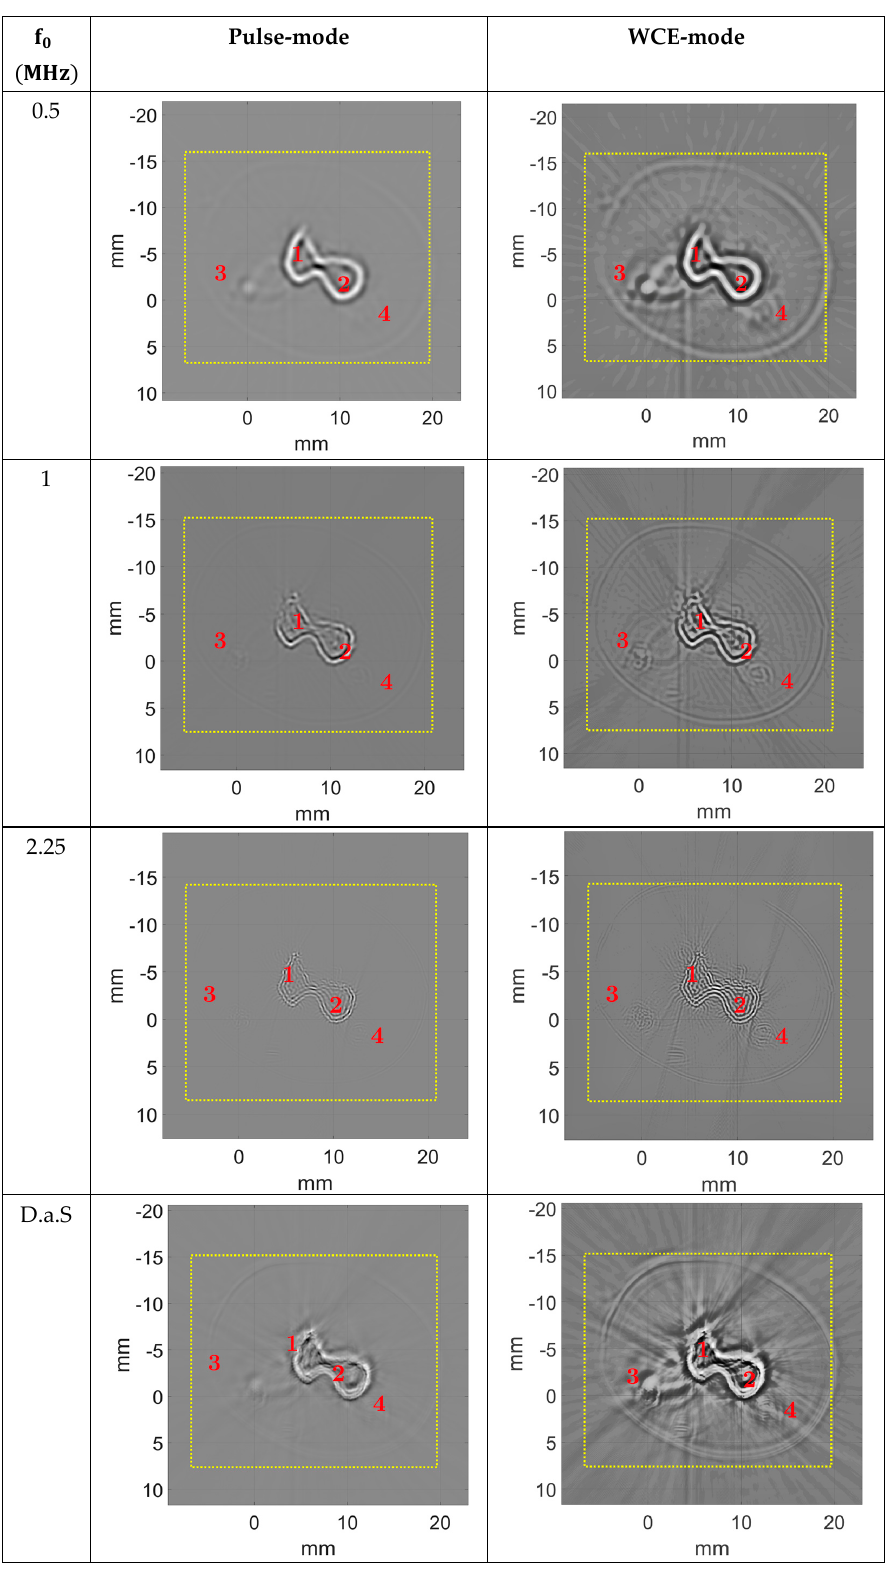
Figure 10. Reconstruction of the newborn arm phantom (True Phantom Solutions) (H1) obtained using reflection-mode USCT algorithm in pulse-mode ( left ) and WCE-mode ( right ), with 720 signals and 65,536 samples per signal. Image size: 2048 × 2048 pixels 2